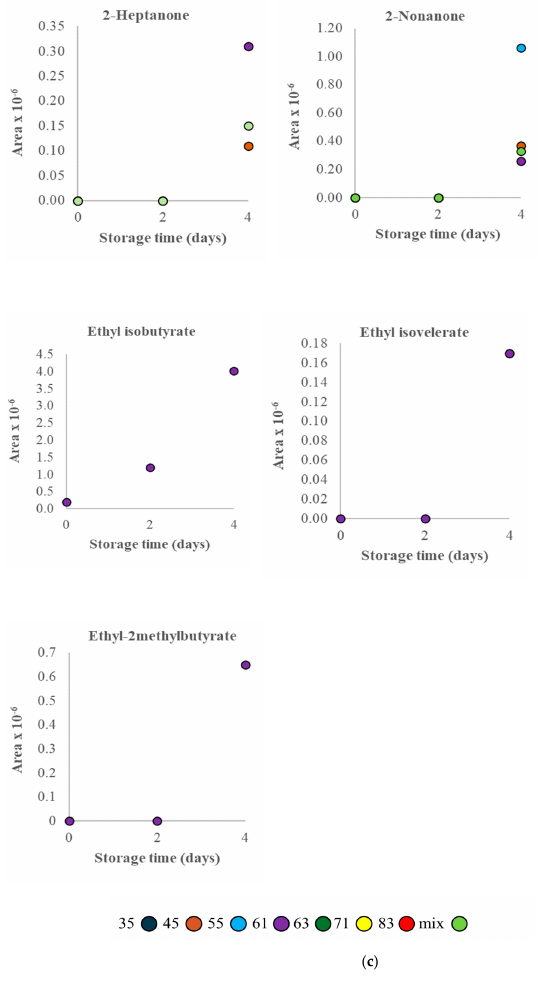
Figure 2. Volatile organic compounds that increased during storage in inoculated FJA model sub- strates at 0 °C ( a ), 4 °C ( b ) and 8 °C ( c ).